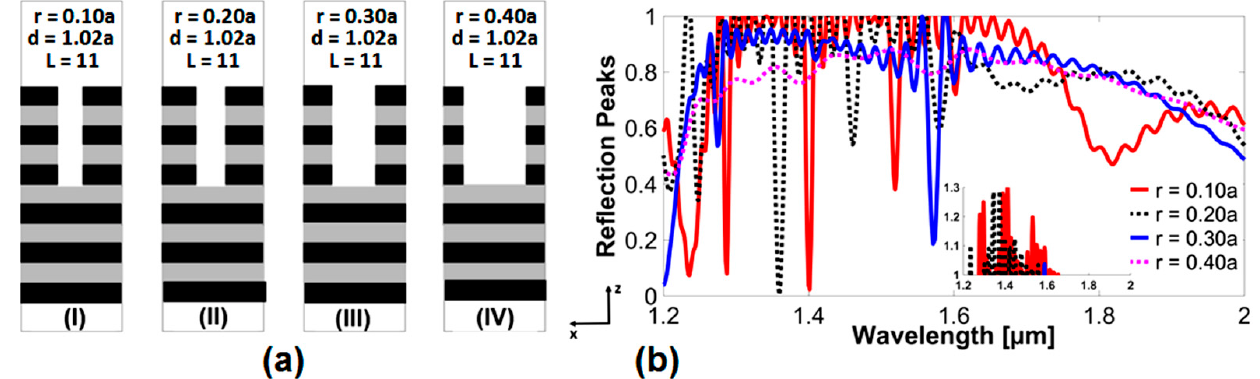
Figure 6. ( a ) DBR structure with PhC holes reaching up to fifth layer and radius varying between (I) 0.1 a , (II) 0.2 a , (III) 0.3 a , and (IV) 0.4 a . ( b ) Reflection spectra of DBR-PhC structures for variation in value of hole radius in five DBR layers.